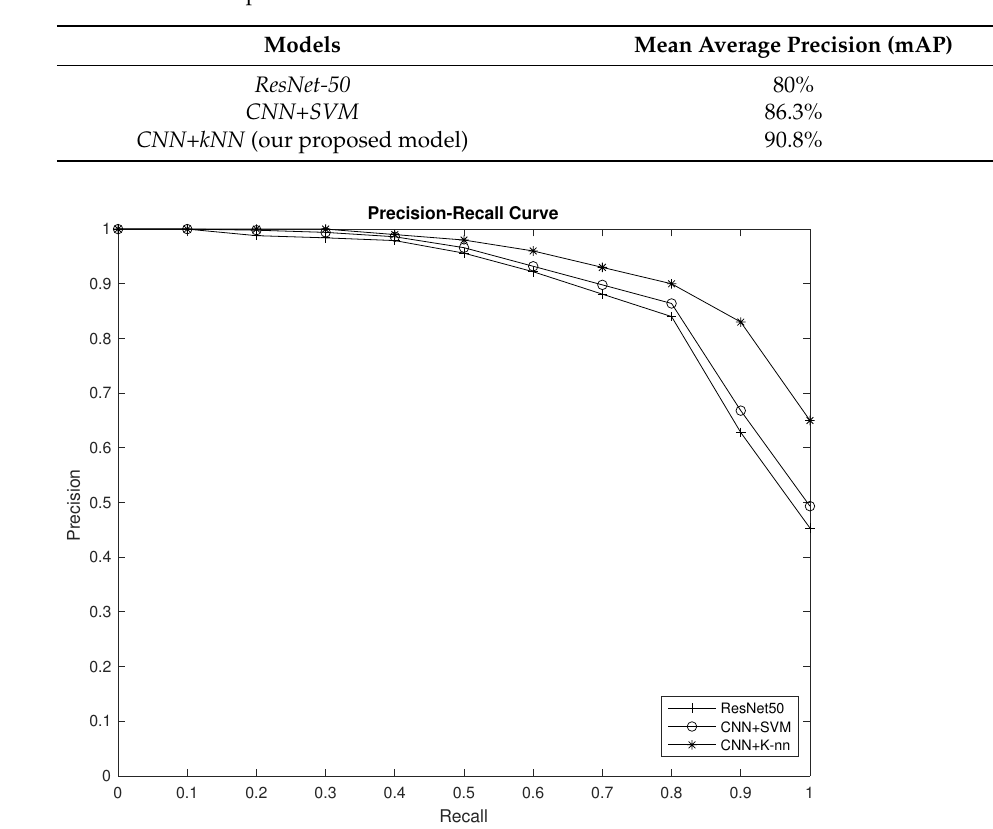
Figure 9. Precision–Recall curves of three pill identification models: ResNet-50 , CNN+SVM , and CNN+kNN